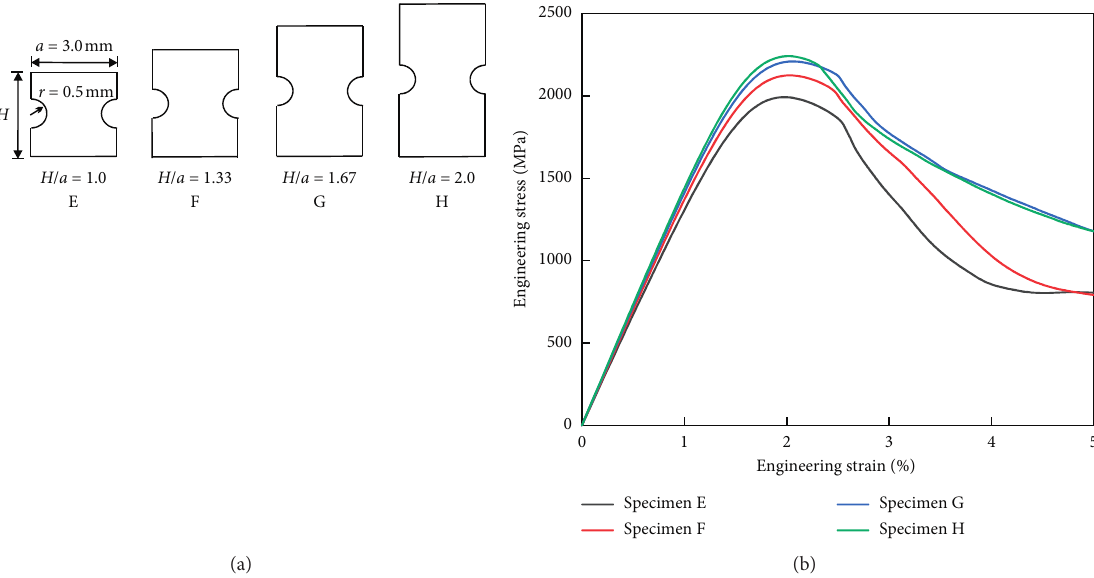
Figure 11: (a) Configuration of notched samples with different aspect ratios H / a from 1.0 to 2.0, marked as specimens E–H. (b) Compressive engineering stress-strain curves for samples E–H.